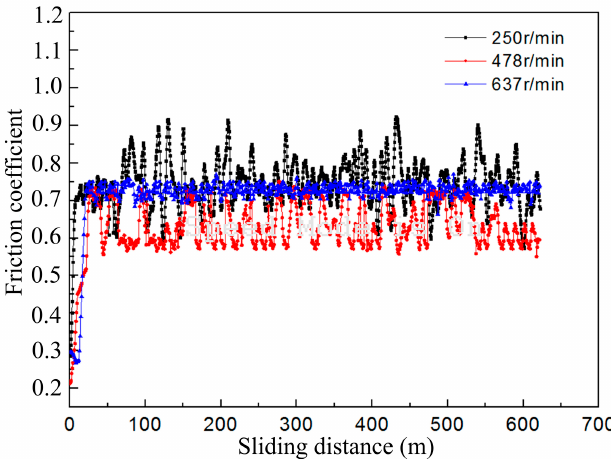
Figure 5. Friction coefficients of UIRP samples undergoing 3000 cycles at different sliding speeds.